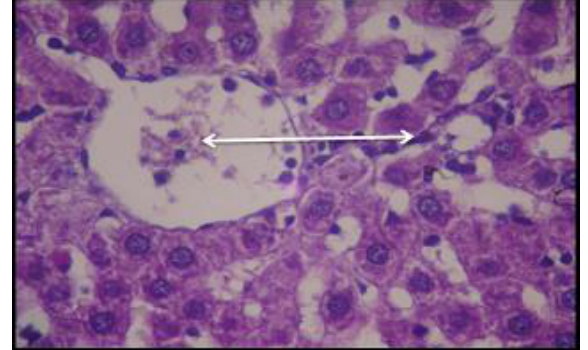
Figure,7: Photomicrographs showing histology of liver tissue from group T2 showed MNCs infiltration in liver parenchyma consist mainly of macrophage (H -E X 10).